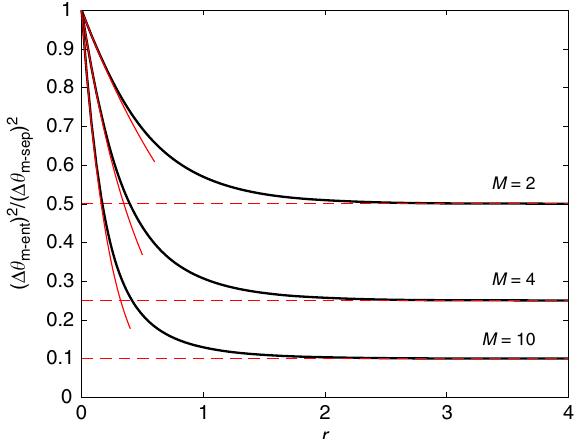
Fig. 4 Quantum gain from nonlocal mode entanglement. We plot the ratio between the sensitivity to an uniform average of parameters ( Δ θ ) 2 = n T Σ n for optimal mode-entangled and mode-separable states (thick black line), as a function of the squeezing parameter r . The solid red lines are the small- ffiffiffi M p (cid:2) 1 Þ r and the dashed red lines are the large- r r approximation e (cid:2) 2 ð approximation 1/ M . Different sets of lines refer to different values of M